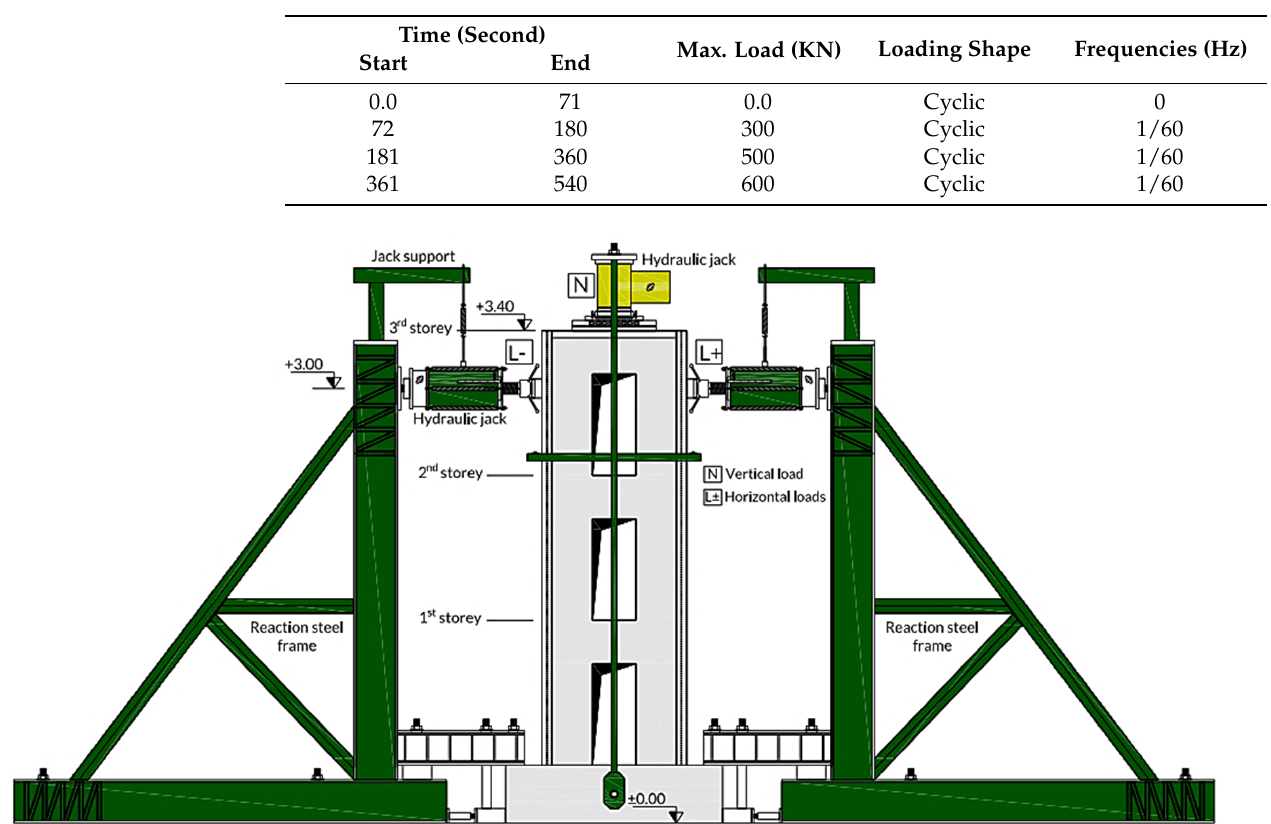
Table 1. Details of the experimental specimens and mechanical properties.